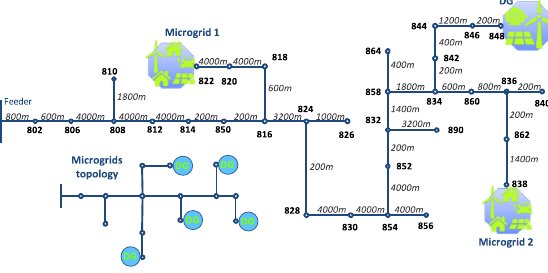
Fig. 5 Topology of the test feeder